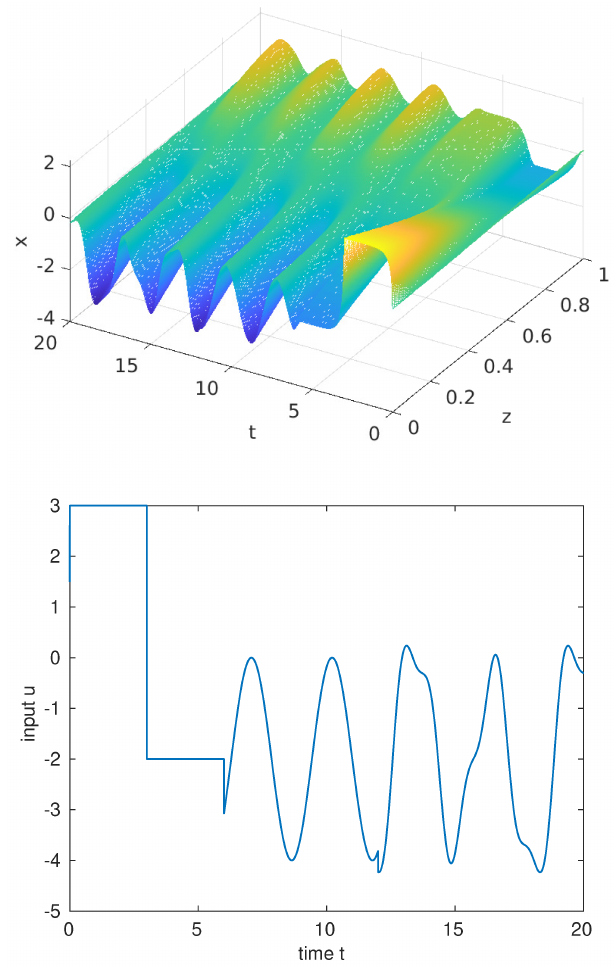
Figure 1. Solution of the pde model (1) using finite-difference approximation with N = 100 colloca- tion points ( top ) and corresponding input ( bottom